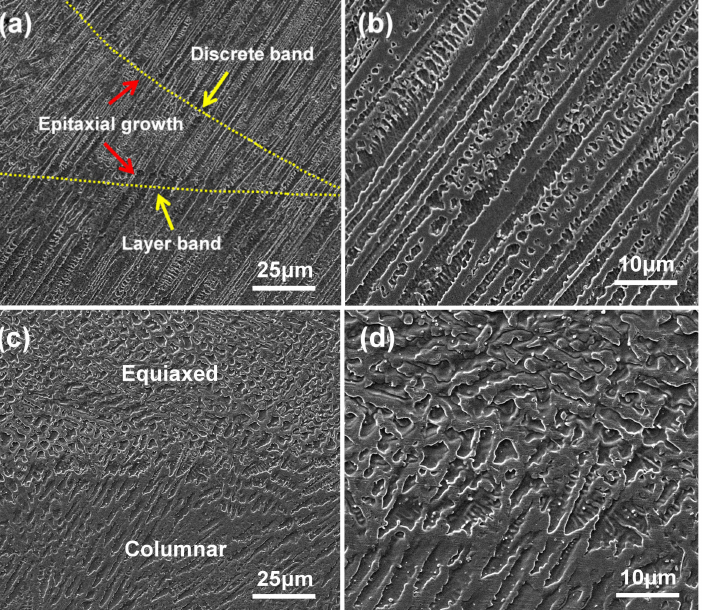
Figure 4. Longitudinal cross-sectional SEM micrographs of as-fabricated samples under different scanning strategies: ( a , b ) SDS and ( c , d ) CDS.